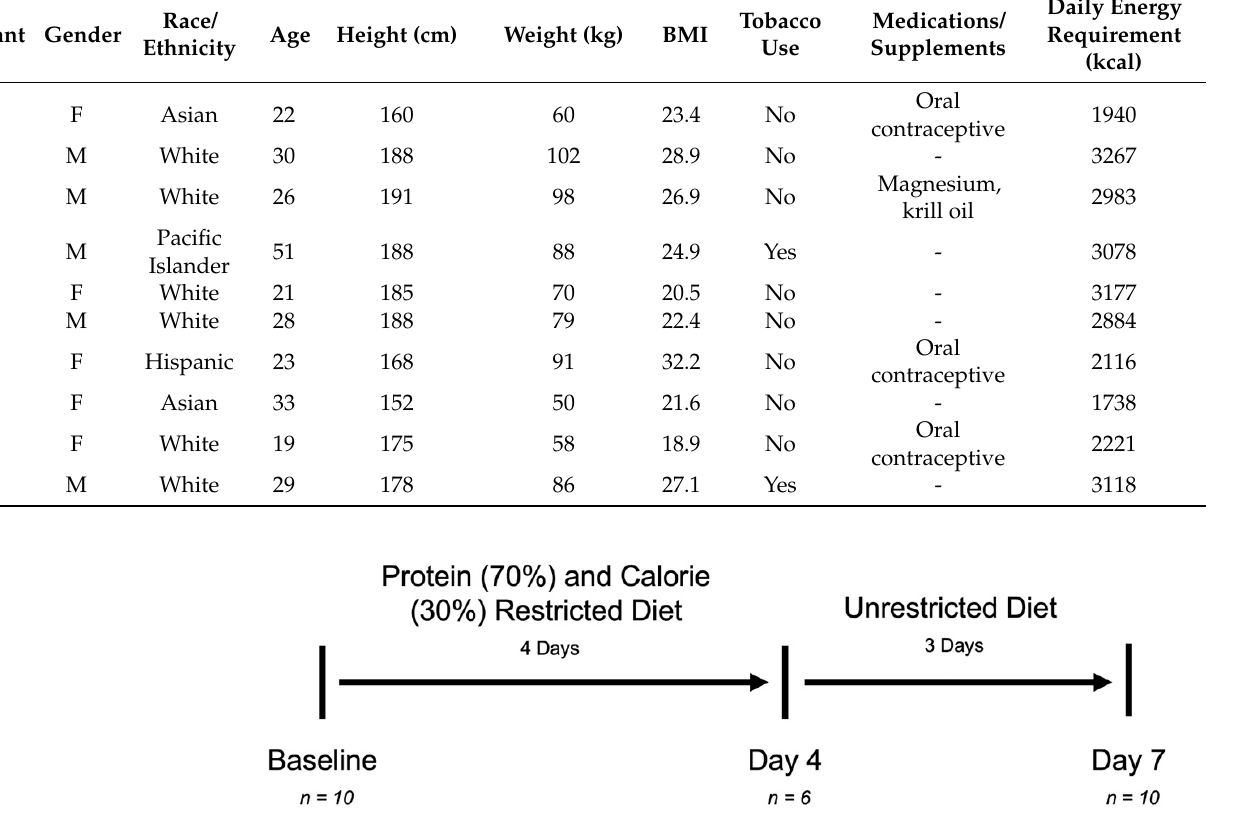
Table 1. Participant characteristics.